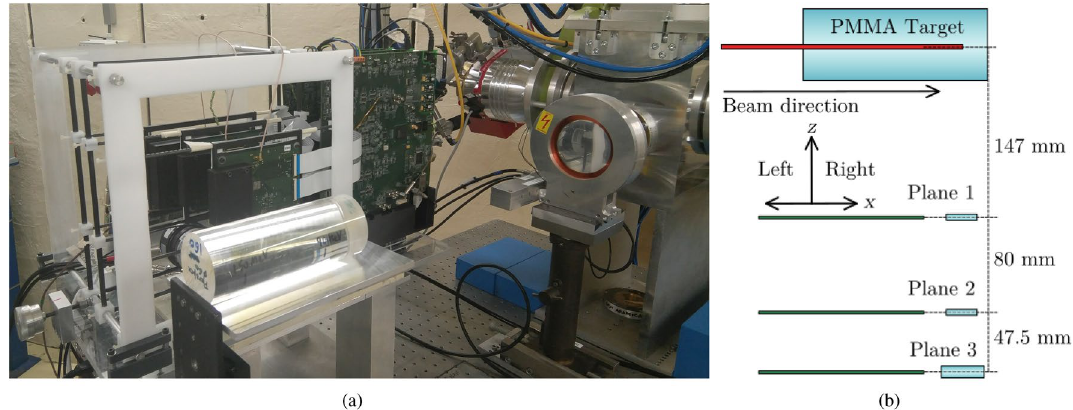
Figure 6. ( a ) Picture of the experimental set-up showing beam exit, PMMA target and Compton camera. ( b ) Diagram of relative distances in the experimental set-up.